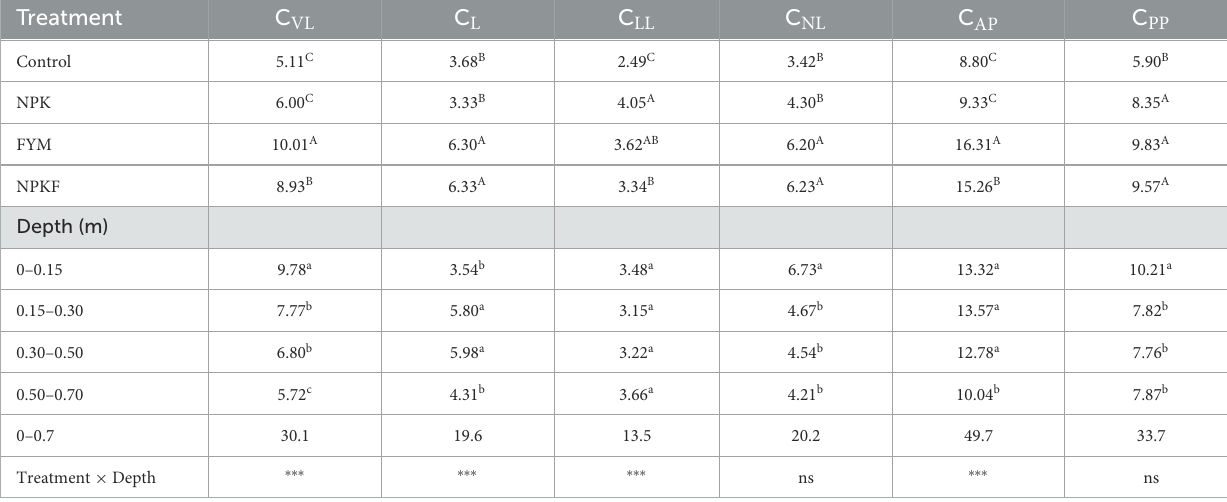
TABLE 3 Changes in soil organic C pools (Mg ha − 1 ) with nutrient management in soil